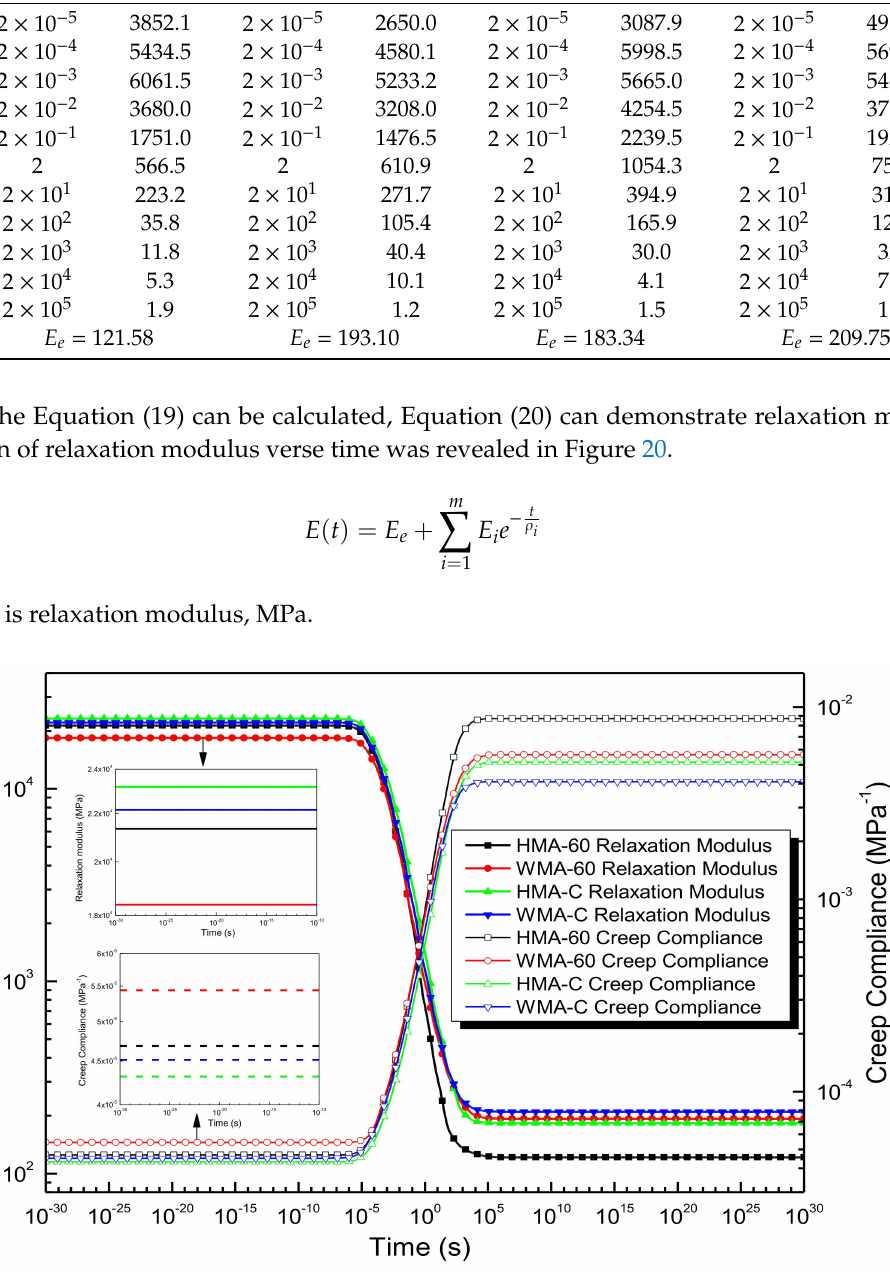
Figure 20. Relaxation modulus and creep compliance of the asphalt mixtures